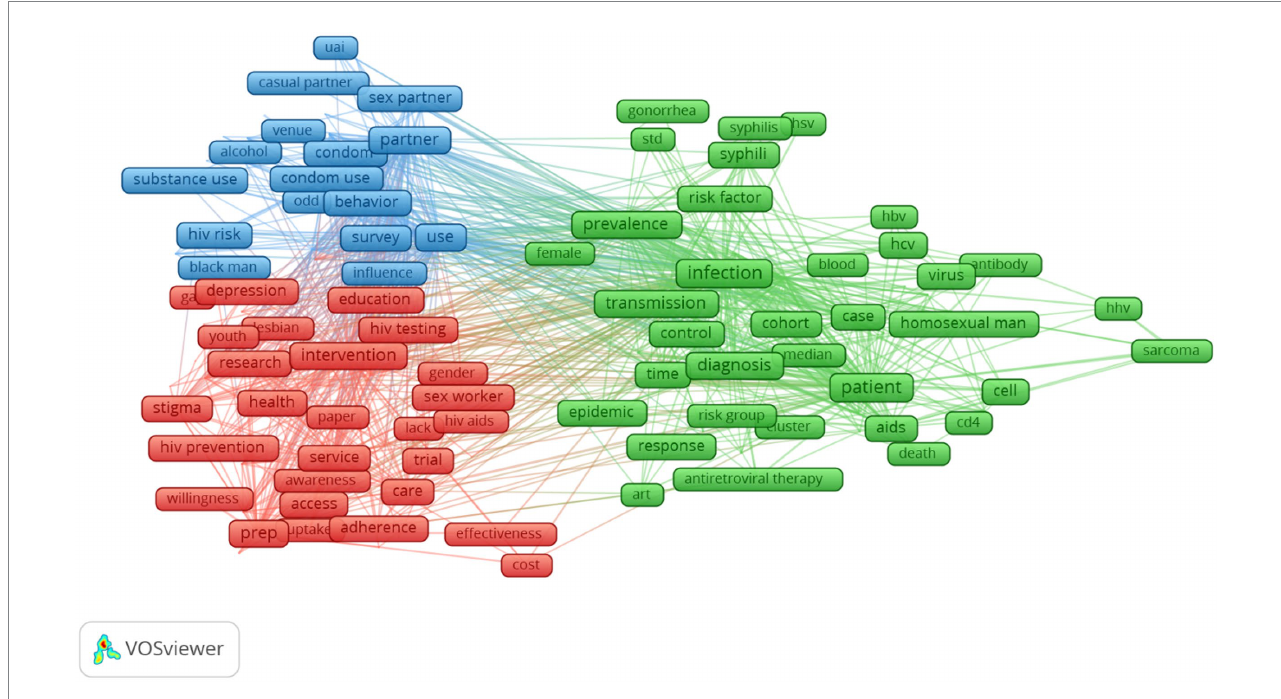
FIGURE 4 Co-occurrence of most frequent terms in titles and